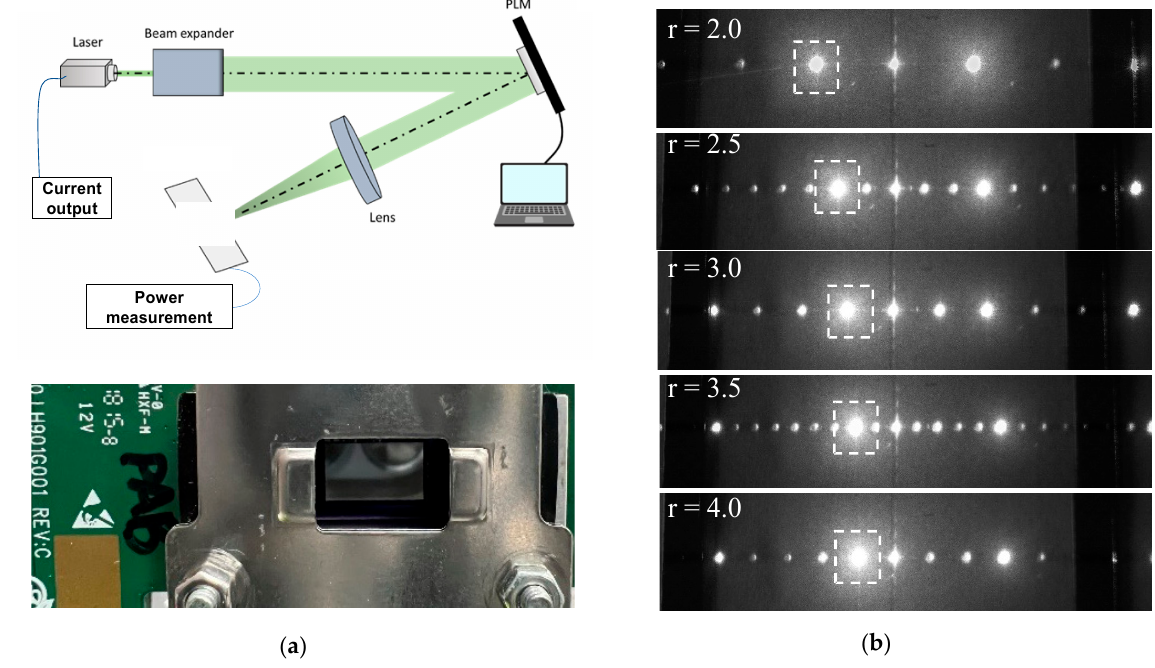
Figure 4. ( a ) Experimental setup. A 532 nm CW laser passing through the beam expander is phase- modulated by TI-PLM, as pictured; ( b ) beam steering pattern for period number r = 2.0, 2.5, 3.0, 3.5, and 4.0.